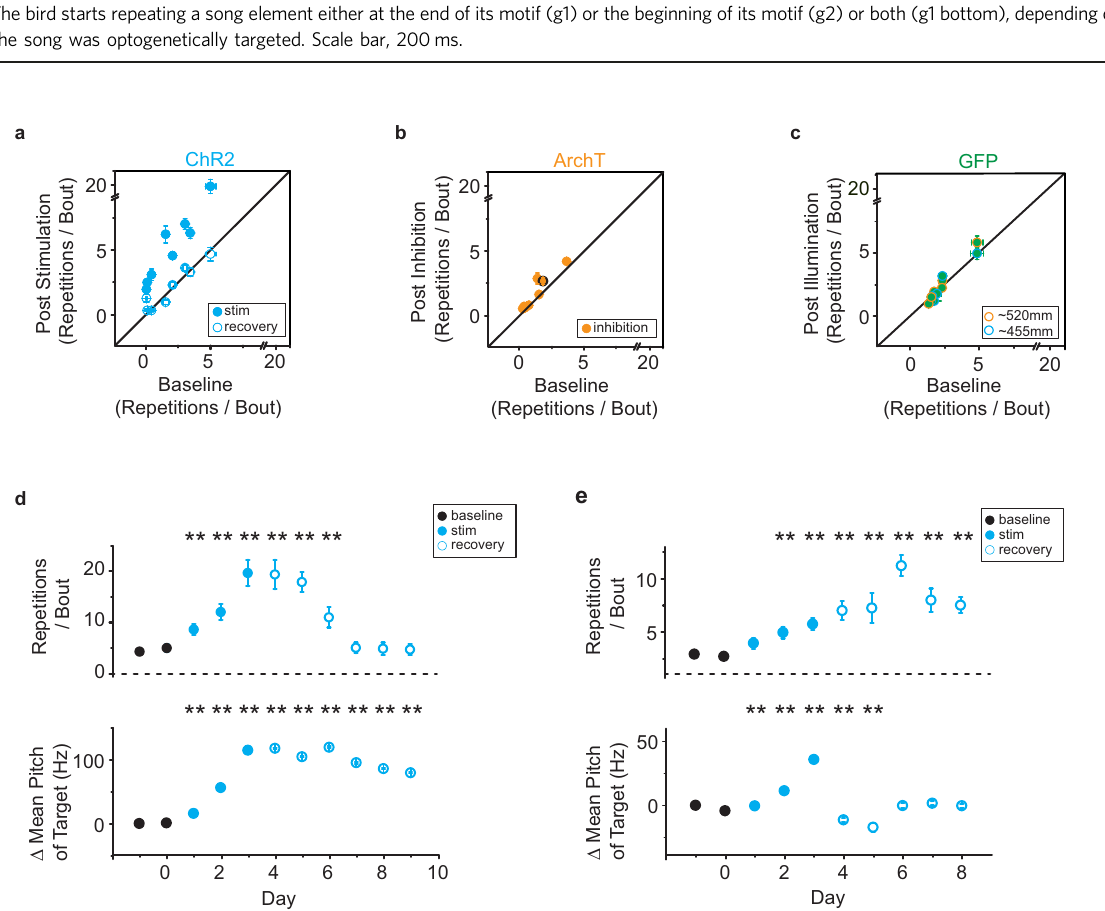
Fig. 7 Song contingent excitation of dopamine terminals in Area X induces dys fl uent repetition of song syllables. a Schematic of experimental design for optogenetic manipulation of dopamine release from VTA terminals in Area X. b Representative coronal section through VTA showing that most neurons infected with optogenetic constructs are TH-positive and located in the ventral and ventrolateral portions of VTA. Scale bar, 50 µ m. c Schematic of closed-loop optogenetic experimental paradigm. d Average shift in mean pitch, expressed in units of | d ′ |, for ChR2 + birds (| d ′ | = 1.33±0.6[mean±SEM], n = 6 birds), ArchT + birds (| d ′ | = 1.47±0.59[mean±SEM], n = 6 birds), and GFP + birds (| d ′ | = 0.35±0.077[mean±SEM], n = 6 birds). Average shift in mean pitch for both ChR2 + and ArchT + birds were higher than 0.75, and also signi fi cantly higher than control GFP + birds (ChR2 + , p = 0.0025; ArchT + , p = 0.0025; Kruskal – Wallis test). Box indicates the median±SD. e Changes in the number of repetitions of vocal element per song bout between the baseline day and last illumination day, expressed in units of d ’ , for ChR2 + birds ( d ′ = 2.02±0.5[mean±SEM], n = 6 birds), ArchT + birds ( d ′ = 0.46±0.21[mean±SEM], n = 6 birds), and GFP + birds ( d ′ = − 0.015±0.2[mean±SEM], n = 4 birds). Change in the number of repetitions of vocal elements in ChR2 + birds were signi fi cantly greater than change in GFP + birds ( p <0.0001, Kruskal – Wallis test), but there was no signi fi cant difference between ArchT + and GFP + birds ( p = 0.12, Kruskal – Wallis test). Box indicates the median±SD. f Spectrograms of song recorded from a ChR2 + bird at baseline, 3rd stimulation day and 6th recovery day. Light pulses (~455nm, 100ms) were delivered over the target syllable during lower pitch variants but not during higher pitch variants. g Schematic of the experiment in a ChR2 + bird in which light pulses (~455nm, 100ms) were delivered over two different target syllables at different times over the course of 2 months. The bird starts repeating a song element either at the end of its motif (g1) or the beginning of its motif (g2) or both (g1 bottom), depending on which